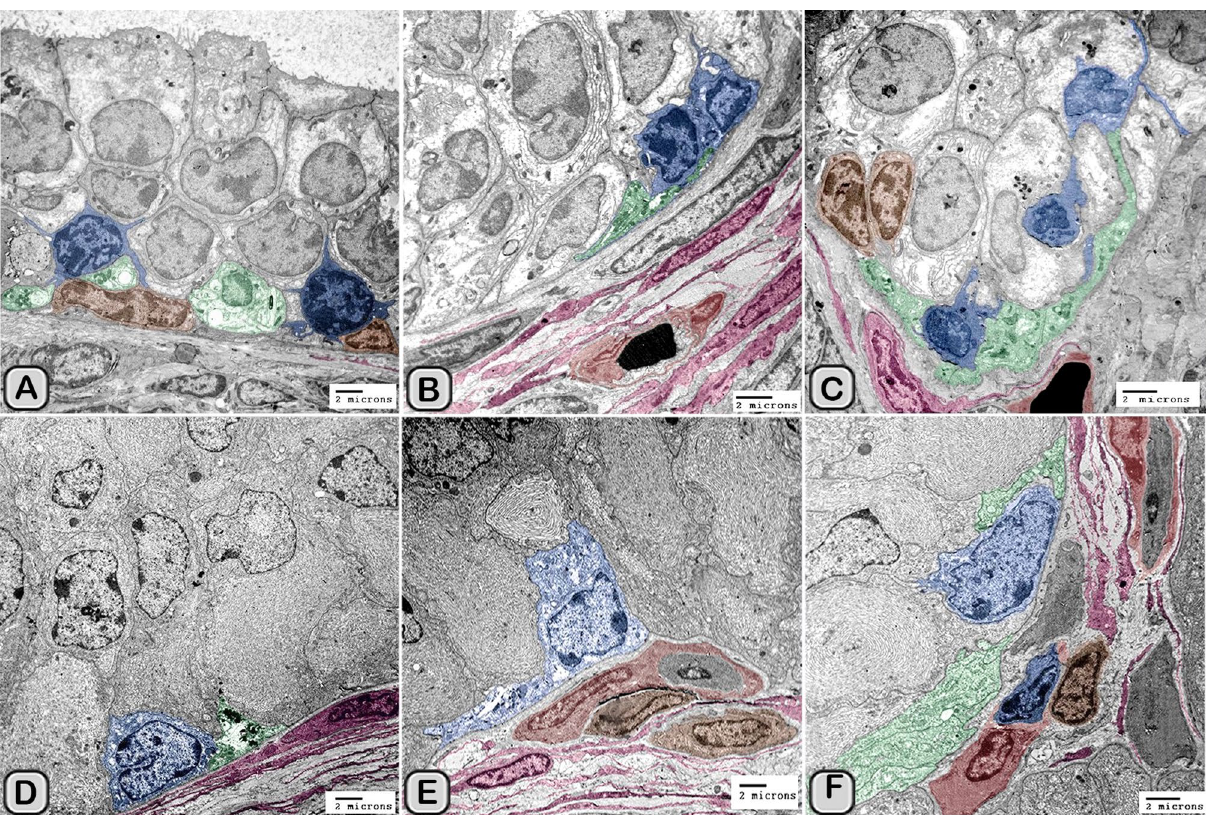
Figure 10. Digitally colored transmission electron microscope images of the dendritic cells in the seminal vesicle of the soay ram. (A–C) General morphology of the dendritic cells in the glandular epithelium lining the seminal vesicle of the control groups. The dendritic cells (blue) had a deeply indented nucleus and a great amount of the peripheral heterochromatin (HC). The DCs (blue) were observed in association to the T-lymphocytes (brown), nerve fibers (green) and telocytes in the interstitium (pink). (D–F) General morphology of the DCs in the glandular epithelium lining the seminal vesicle of the melatonin treated groups. The nucleus of the DCs (blue) was euchromatic (EC) (D–F) . DCs varied in shape which could be large polyhedral (D,E) or triangular (F) . DCs were closely associated with lymphoblast (brown) and telocytes